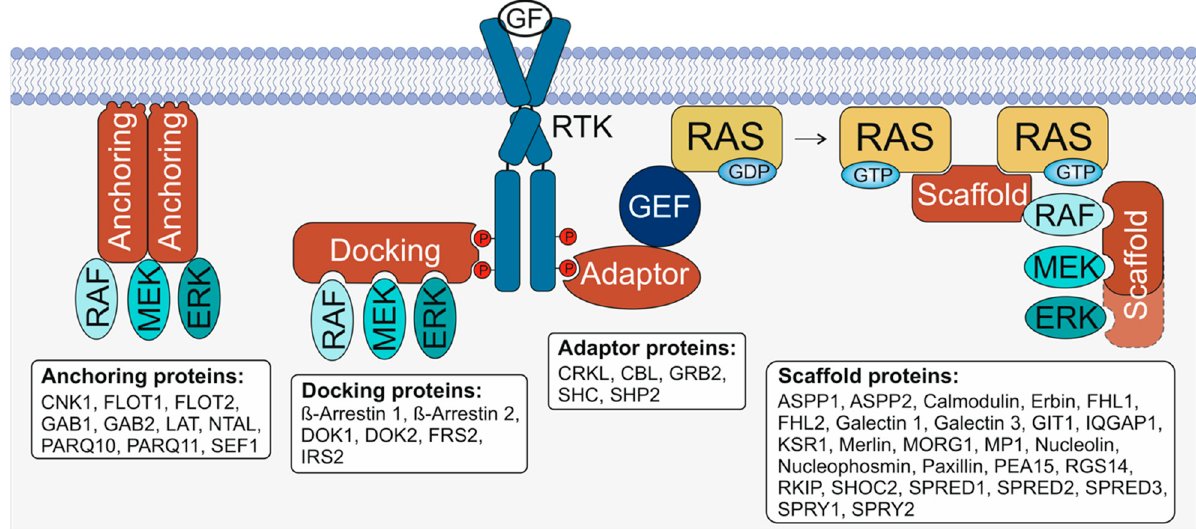
Figure 1. Accessory proteins can be divided into at least four subgroups: anchoring, docking, adaptor, and scaffold proteins. All groups include several different binders of the RTK-RAS-MAPK signaling pathway, such as RAF, MEK, and/or ERK, and often share common domains. Anchoring proteins include membrane-associated domains, such as pleckstrin homology (PH) and transmembrane (TM) domains or a posttranslational modification, (e.g., myristoylation in FLOT2) to determine a special subcellular localization and increase the dwell time of the proteins at the membrane. Docking proteins connect receptors with downstream effectors and feature receptor binding domains, such as PTBs (phosphotyrosine binding domains). FRS2, for example, interacts with the FGFR (fibroblast growth factor receptor) and links activated RTKs (receptor tyrosine kinases) with adaptor proteins such as GRB2 and SHC, and with other effectors, such as SOS1. Adaptor proteins can simply connect two proteins and often exhibit SH (SRC homology) 2 and SH3 domains. GRB2 is a well-known adaptor protein of RTKs and SOS1 but can also, as mentioned before, bind to other accessory proteins and RTKs and fine-tune the signaling machinery and the cross-talk of different pathways. Scaffold proteins can simultaneously bind several signaling components. They can contribute to clustering events by oligomerization via special domains or intrinsically disordered regions (such as galectin 1 and 3), recruit proteins to the site of action (such as SPRED1), or determine RAS signaling at a specific subcellular localization (such as MP1, which binds MEK1 and ERK1 on late endosomes). Scaffold proteins are also able to bind other accessory proteins and allow tight control of the RAS-MAPK pathway.